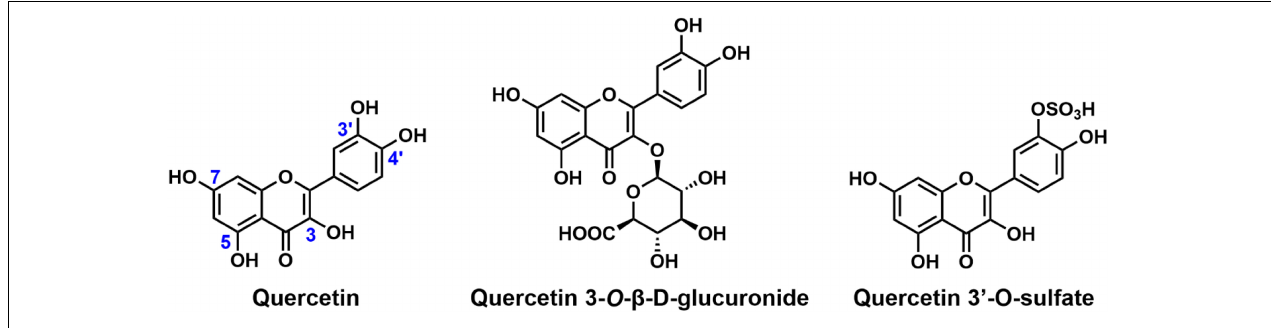
FIGURE 4 | Chemical structures of quercetin and its